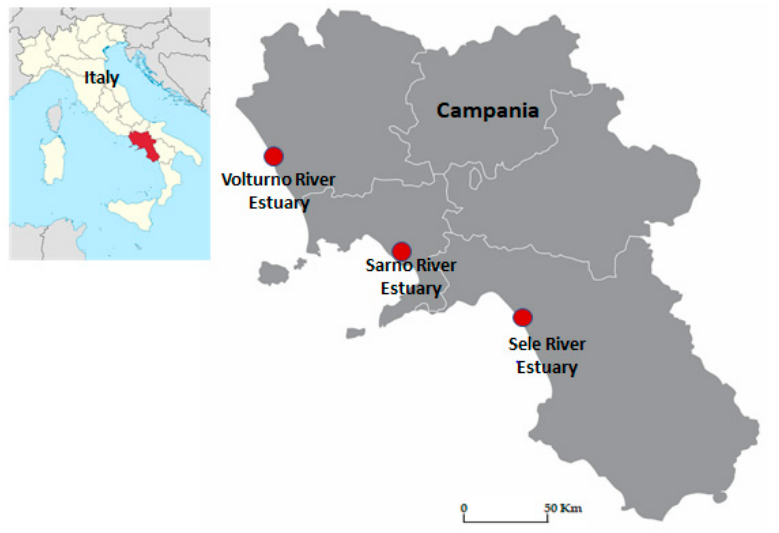
Figure 1. Study Figure 1. Study area.